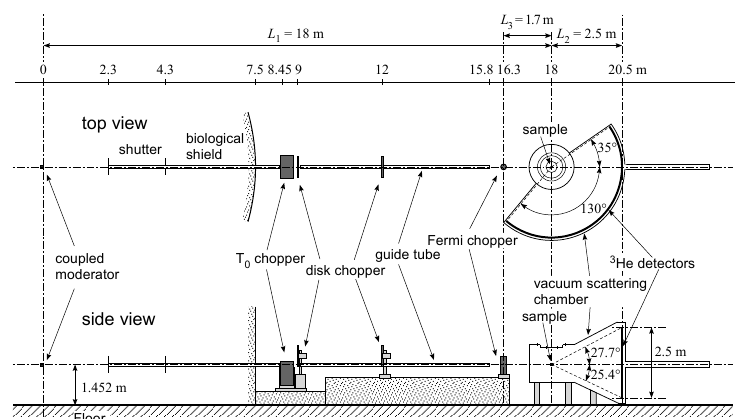
Figure 1. Layout of 4SEASONS